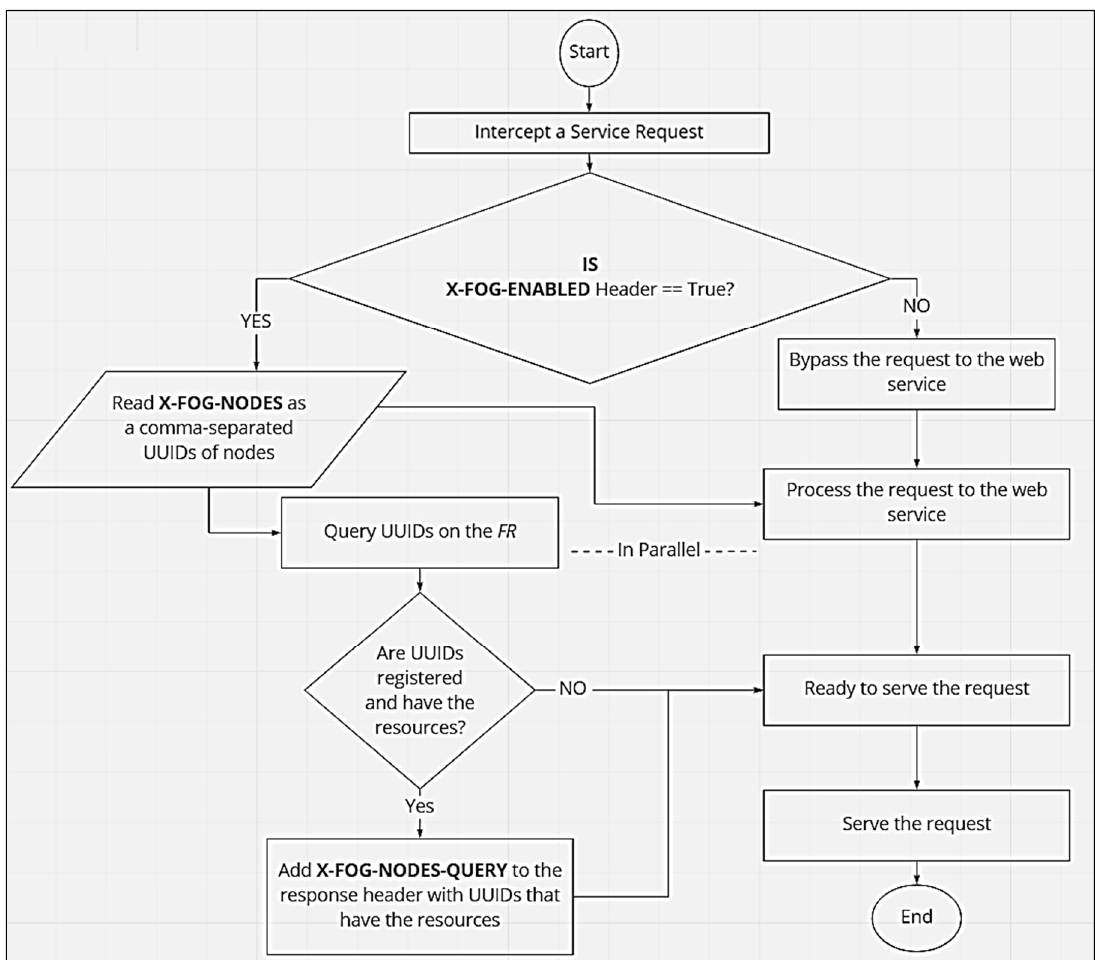
Figure 7. The FSL processes flowchart.